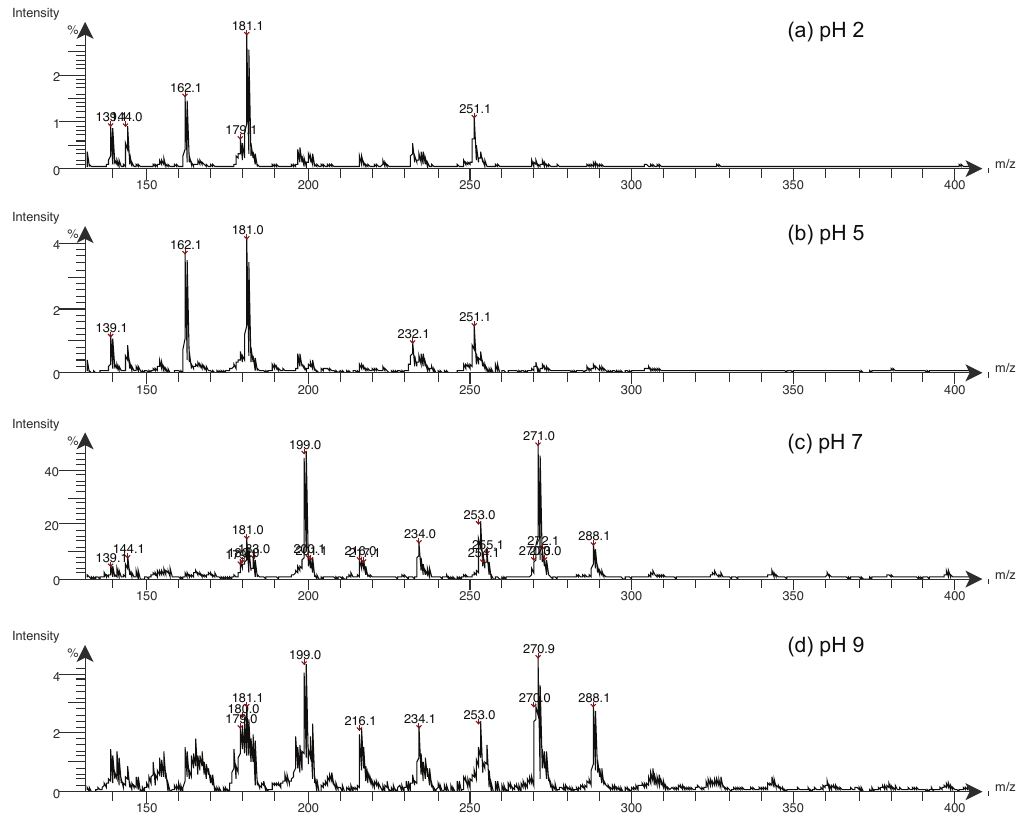
Figure 6. Atmospheric pressure chemical ionization (APCI) mass spectra for m/z greater than 130 for all four initial pH conditions in capped samples after 7 days. Intensity is set to 100% for the largest signal and does not correspond to concentration in the sample itself.